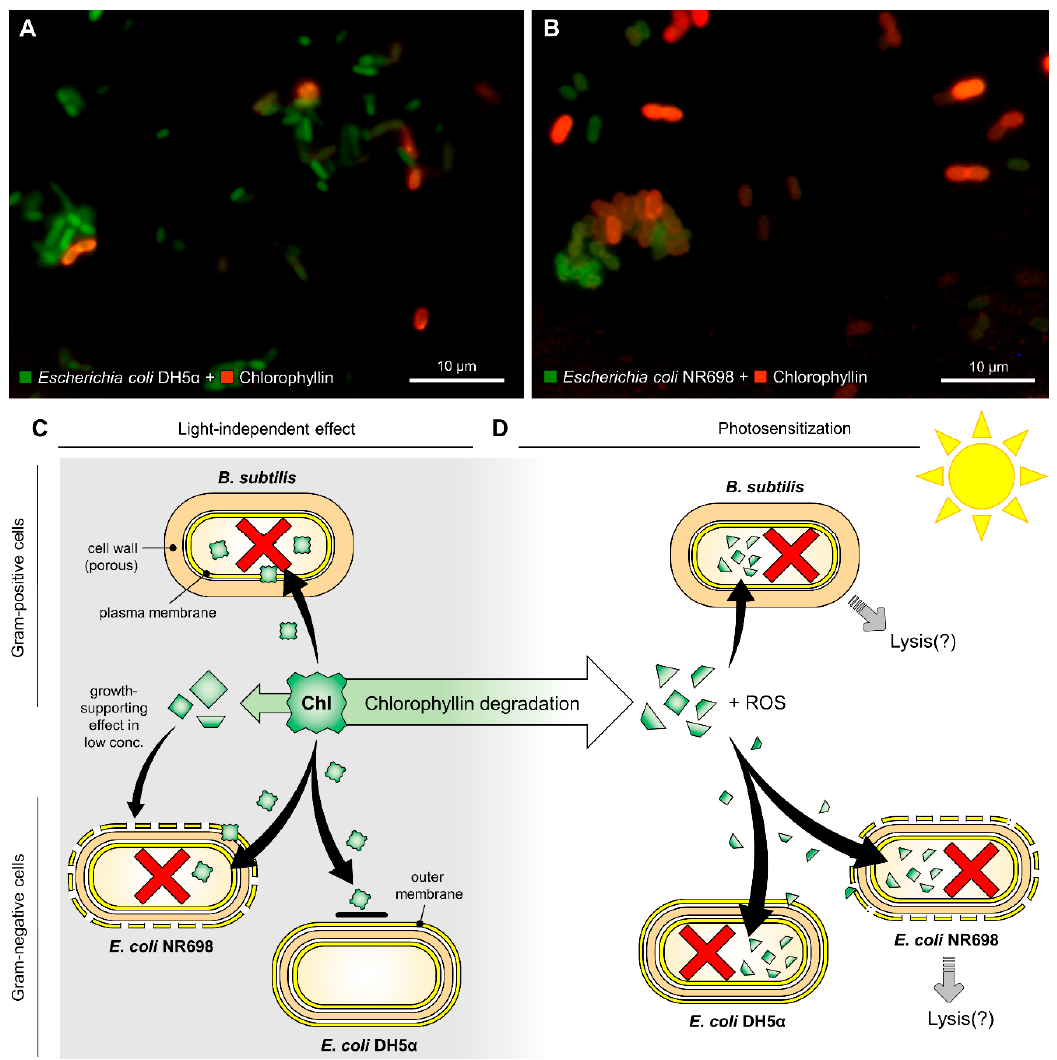
Figure 7. Fluorescence microscopic images of ( A ) Escherichia coli DH5 α and ( B ) Escherichia coli NR698 after exposure to chlorophyllin (red fluorescence). Assumed modes of action of chlorophyllin against Gram-positive and Gram-negative bacteria. ( C ) Chlorophyllin (Chl) molecules cannot pass the intact outer membrane of Gram-negative bacteria. ( D ) Chlorophyllin is degraded in light. Degradation products can enter both Gram-negative and Gram-positive cells. The red crosses indicate cell